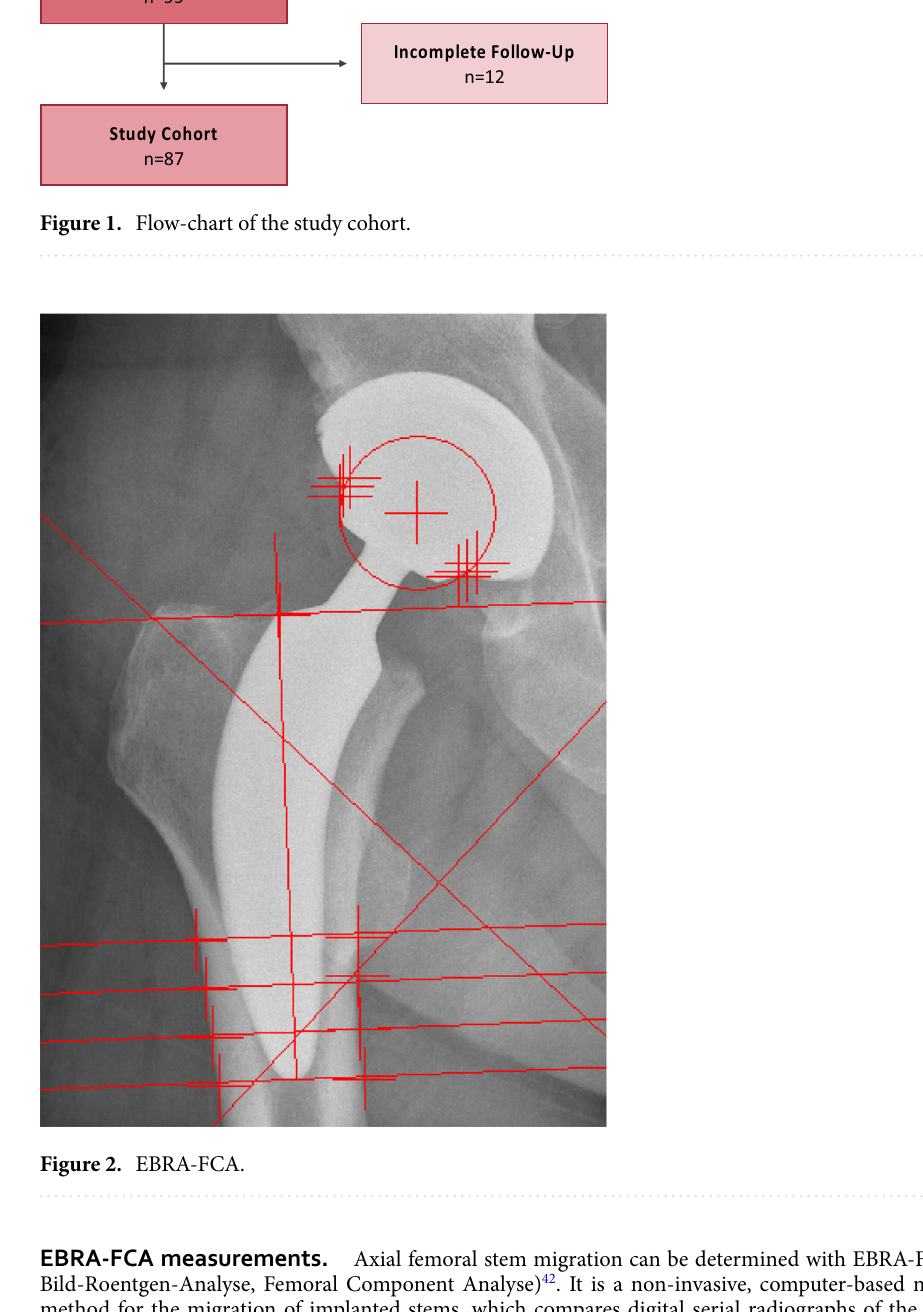
(Fig. 2): measurement of the prosthetic head by placing two lines to the lateral and medial side of the stem, set- ting the so-called “shoulder point”, putting a horizontal line through the trochanter major, positioning two lines to the upper and lower margin of the trochanter minor, placing a horizontal line to the tip of the prosthesis; the final step is to place the “8 pints” at the outmost points of the cortical bone. By this procedure, three parameters can be used for the assessment (Fig. 3): (1) the horizontal distance between the center of the prosthetic head and the shoulder point, (2) the vertical distance between the center of the prosthetic head and the shoulder point,